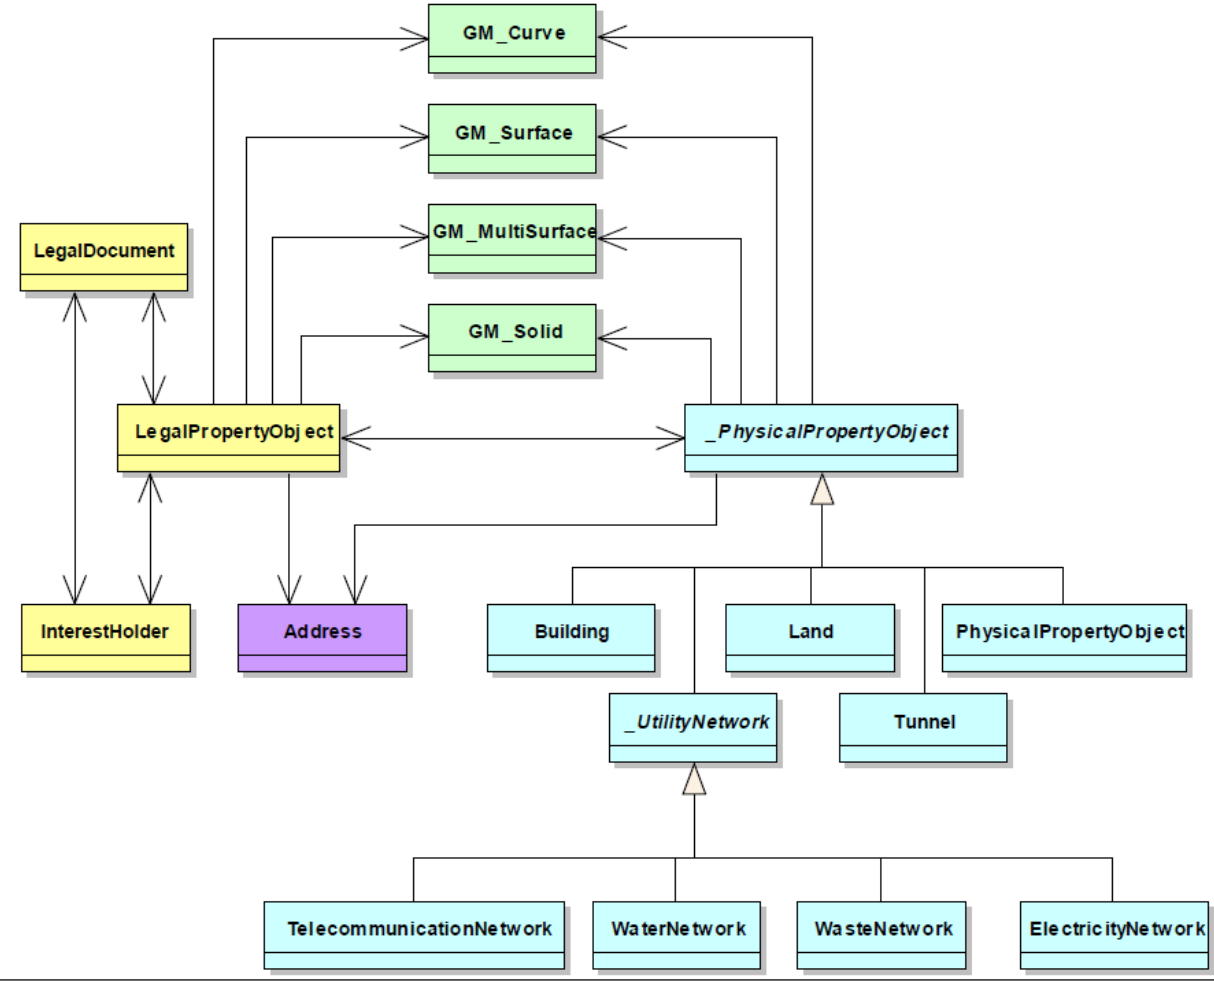
Figure 6. Conceptual model of integrating the legal and physical objects in the 3DCDM